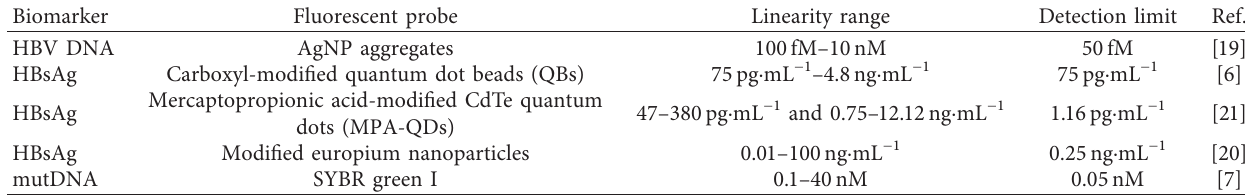
Table 2: Fluorescence detection of